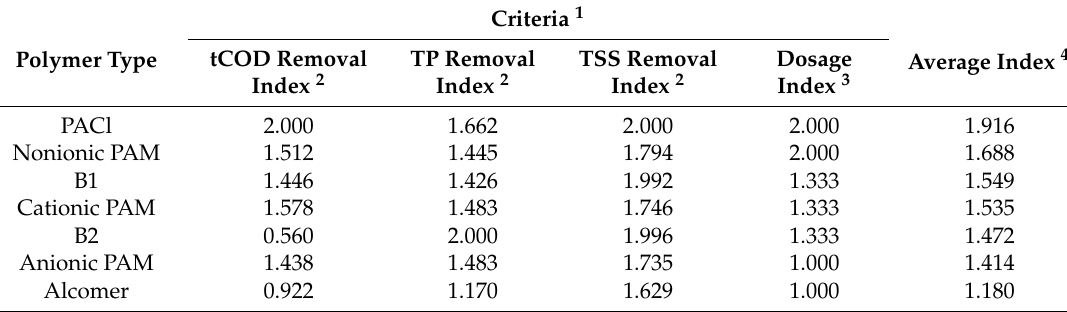
Table 4. Alternative matrix of polymers using equilibrate weight